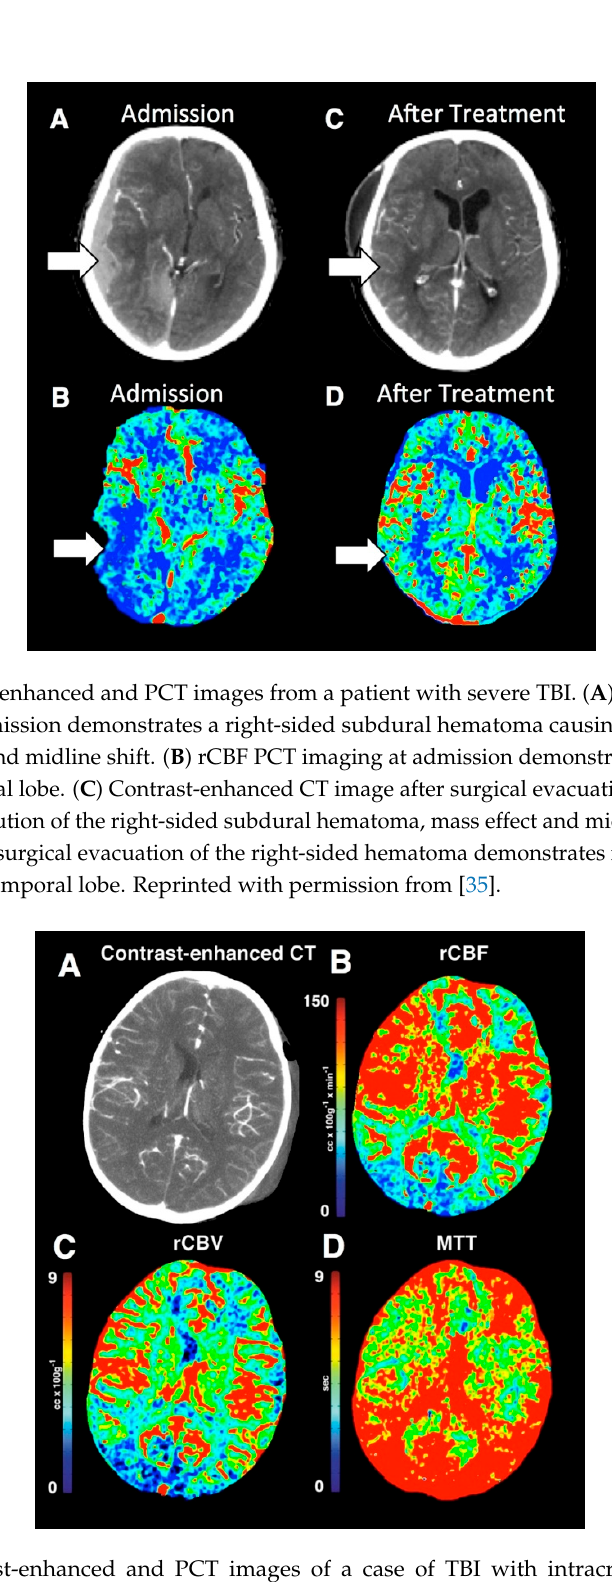
Figure 7. Contrast-enhanced and PCT images of a case of TBI with intracranial hypertension. The contrast enhanced CT ( A ) demonstrated left-sided scalp hematoma. The rCBF ( B ) and rCBV ( C ) trended toward lower values especially in the occipital lobes. The MTT ( D ) demonstrated significantly higher values, reflecting altered cerebral autoregulation after TBI. Reprinted with permission from